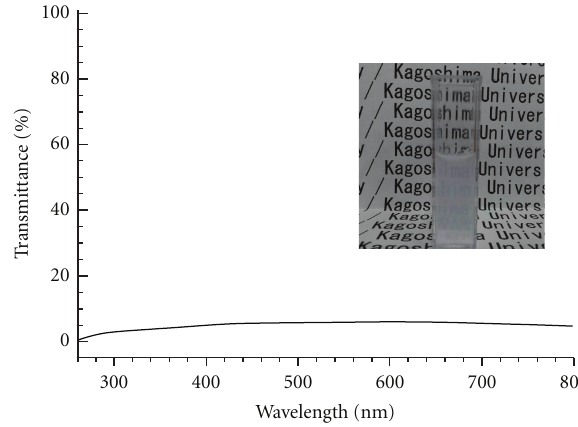
Figure 6: UV-Vis spectrum of aqueous dispersion (1.0w/v%) of the product obtained using 0.1 mol/L aqueous hydrochloric acid as a substitute for methanolic hydrochloric acid in the first-step reaction. The inset shows a photograph of this aqueous dispersion.